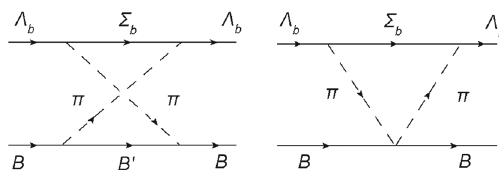
Fig. 7 Examples of two pions exchange in the Y (cid:2) b or N (cid:2) b interac-